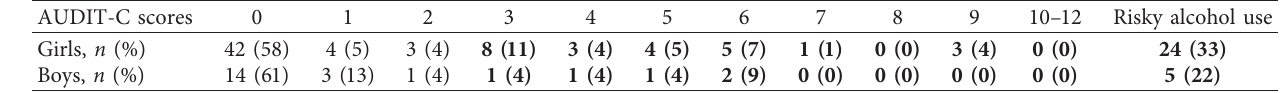
Table 1: AUDIT-C scores from the screening.